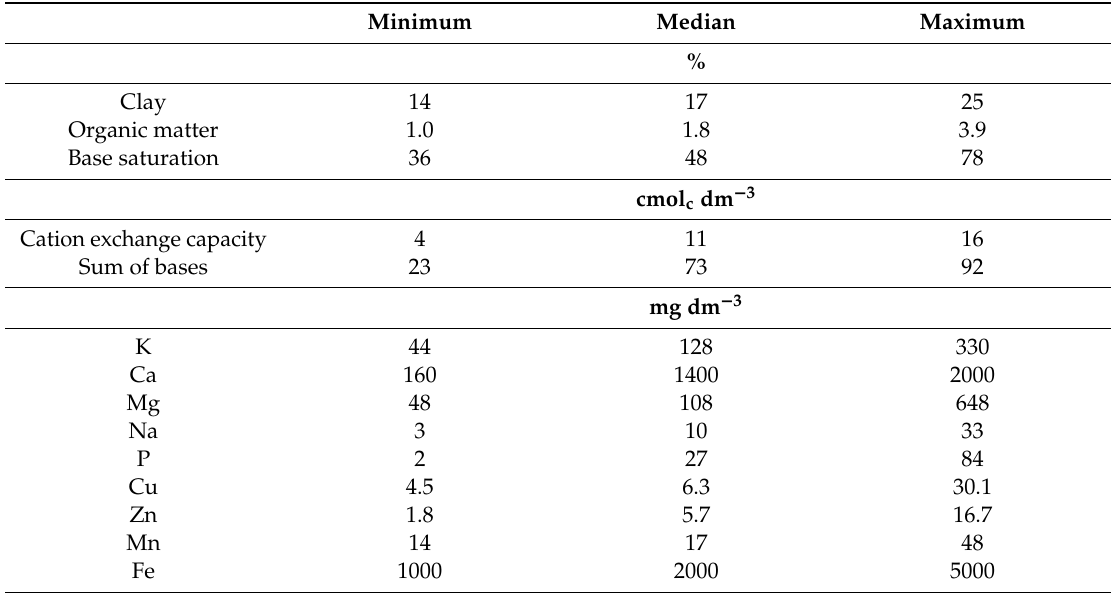
Table 3. Soil analyses reported in peach orchards of experimental sites, Rio Grande do Sul,